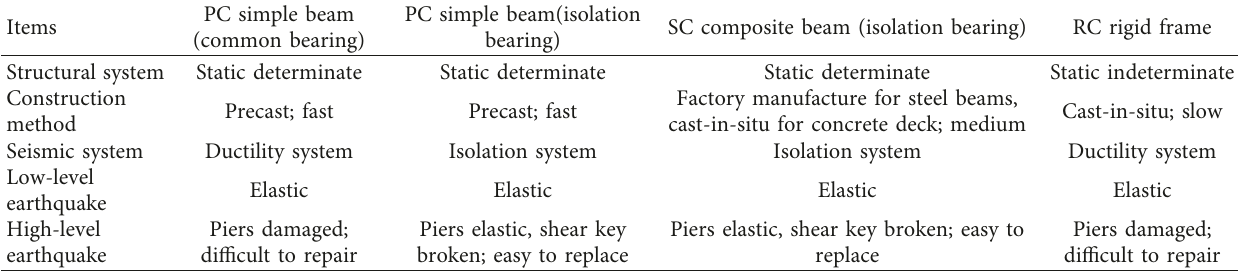
Table 13: Technical comparison of the four earthquake resisting